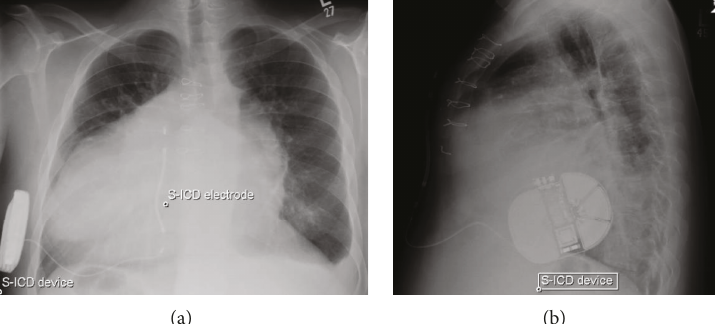
Figure 5: Posteroanterior (a) and lateral (b) chest x-rays showing situs inversus totalis, pectus excavatum, sternal wires from previous cardiac surgeries, and the S-ICD device and electrode. Note the presence of cardiomegaly, small left pleural e ff usion, and basilar atelectasis. S-ICD: subcutaneous implantable cardioverter de fi